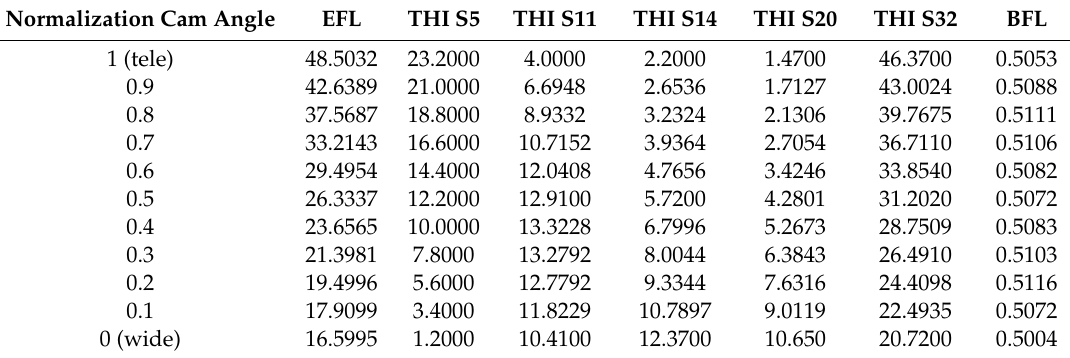
Table 3. Results of Pad é approximation assuming the first lens group moves